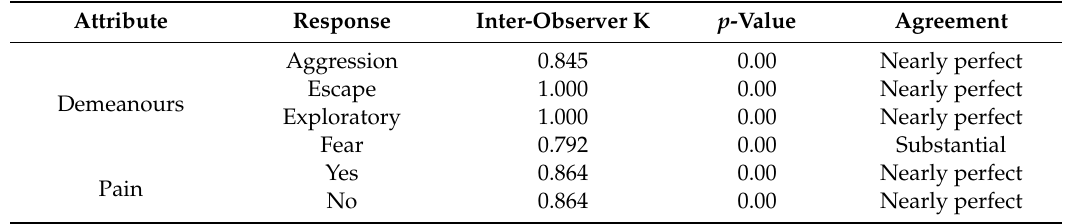
Table 3. Results of the inter-attribute agreement analysis using Fleiss’ Kappa, of inter-observer reliability trial undertaken prior to field trial